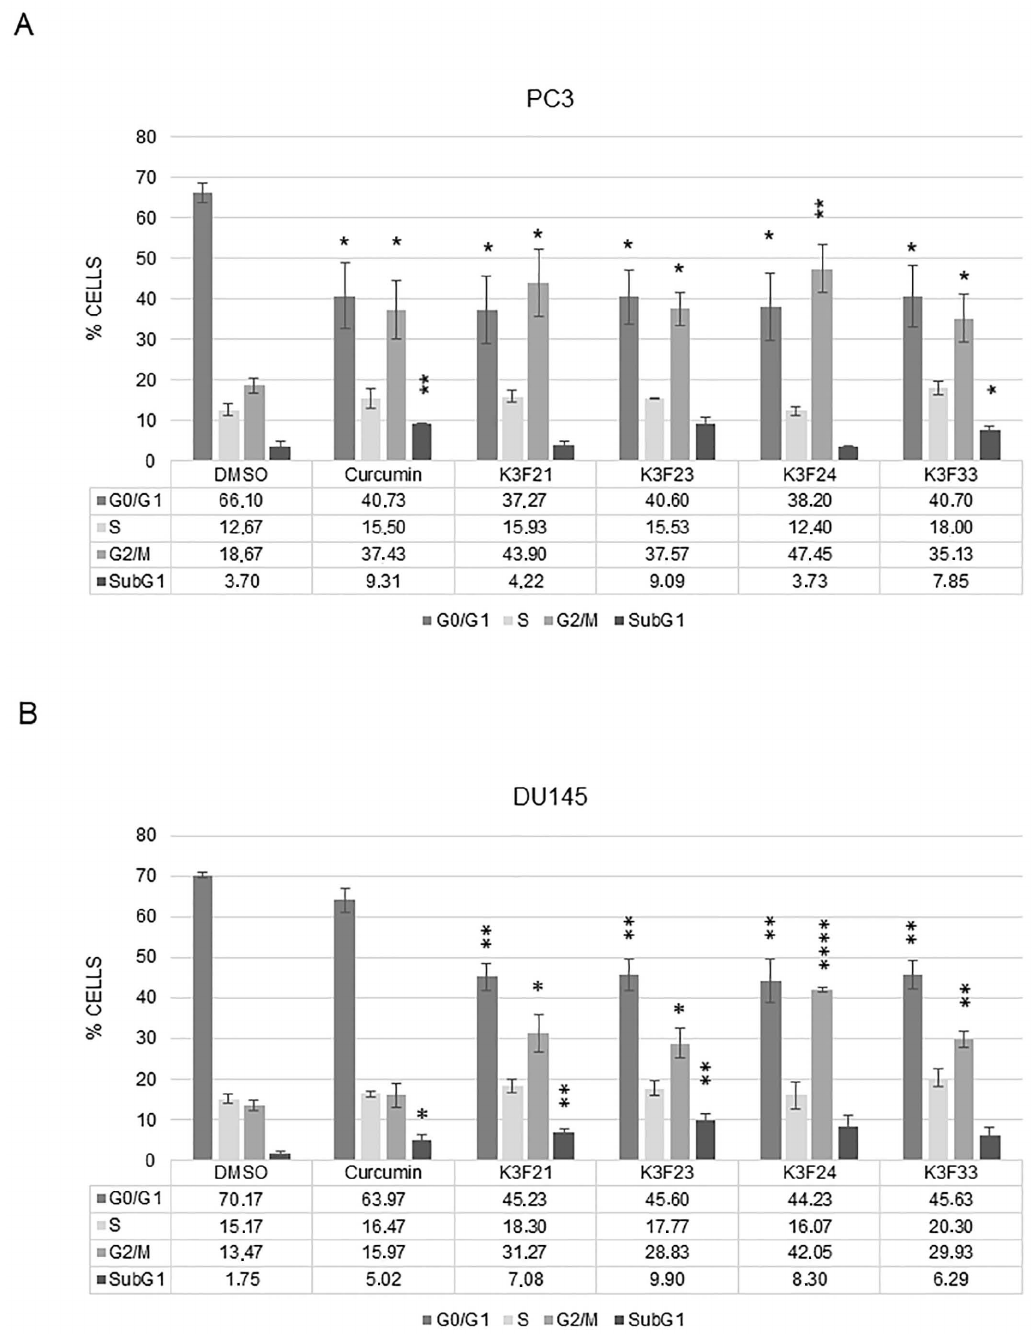
Figure 4. Effects on cell cycle progression of K3F derivatives. Cell distribution between cell